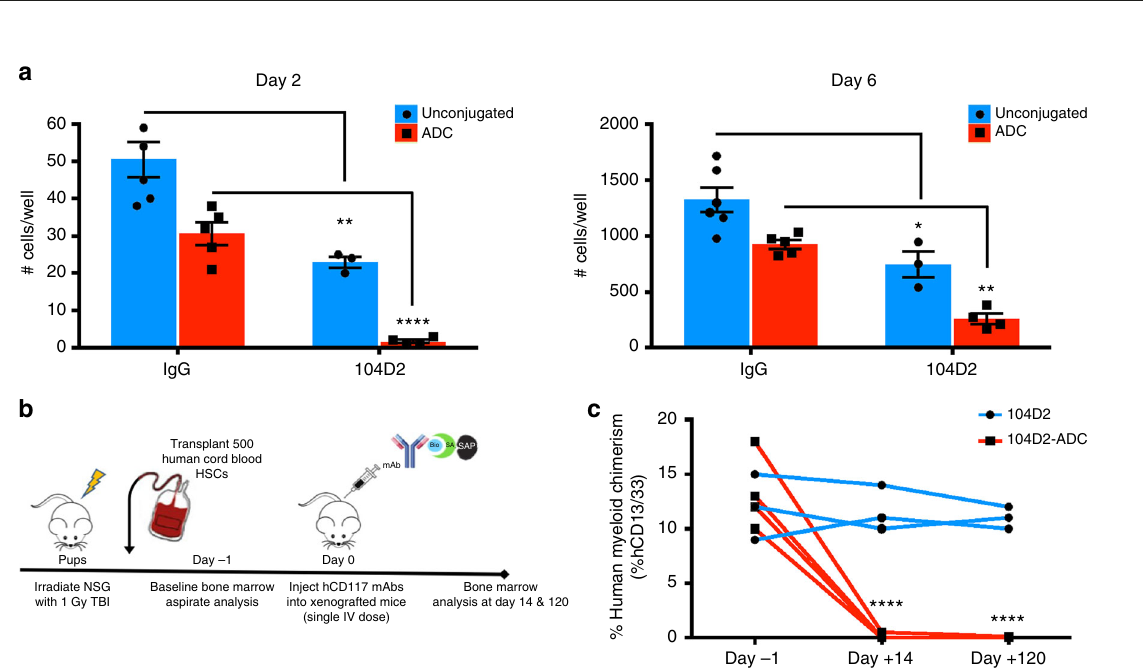
Fig. 6 Human CD117-ADC inhibits human HSCs in vitro and robustly depletes human HSCs in vivo. Human CD117-ADCs were prepared similarly by conjugating biotinylated anti-human CD117 (104D2 clone) with streptavidin – saporin toxin. a Human CD117-ADC inhibited human cord blood growth in vitro, as compared to unconjugated antibody controls. b Experimental outline for assessing the ability of anti-CD117 antibodies and antibody-drug- conjugates to deplete human HSCs in xenograft mice. c Only antibody conjugated to saporin is effective at eliminating human myeloid cells. Data represent mean ± SEM ( n = 3 – 5 samples/group, assayed individually). Statistics calculated using unpaired t test; all data points signi fi cant as indicated vs. unconjugated antibody-treated control animals (* P < 0.05; ** P < 0.01; **** P <